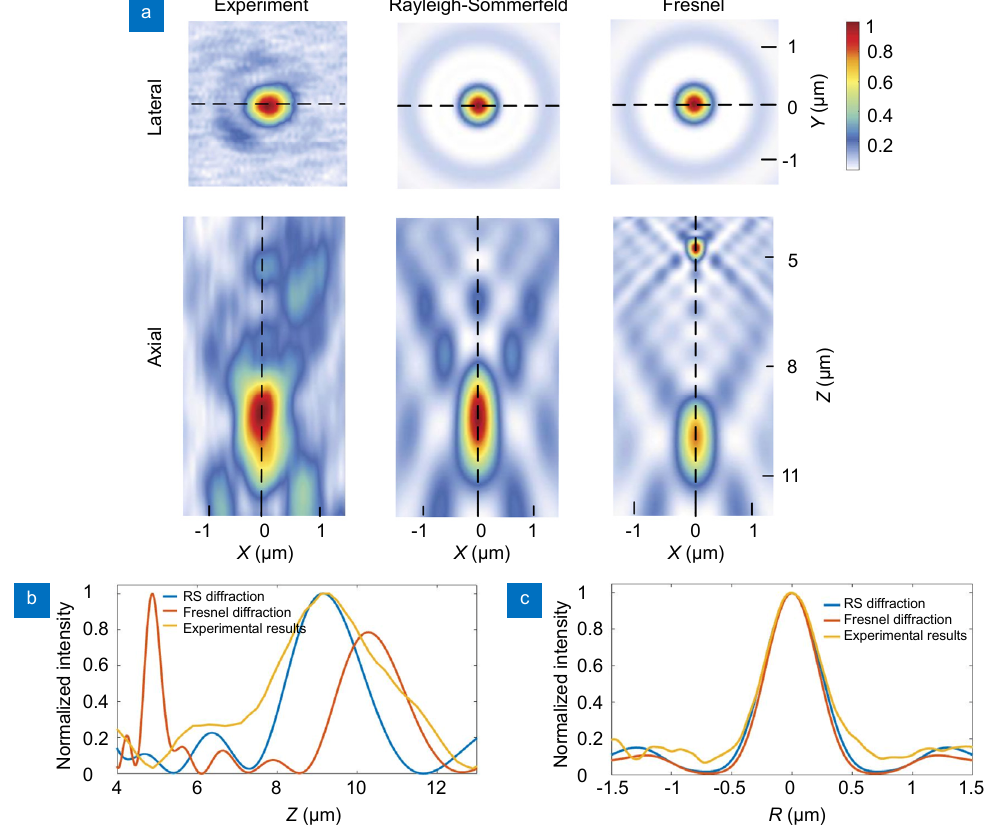
Fig. 5 | Intensity distributions of theoretical and experimental results of Lens 2 . ( a ) Intensity distributions in the lateral and axial planes. ( b ) Intensity distributions along the black dash lines in the axial planes. ( c ) Intensity distributions along the black dash lines in the lateral planes.